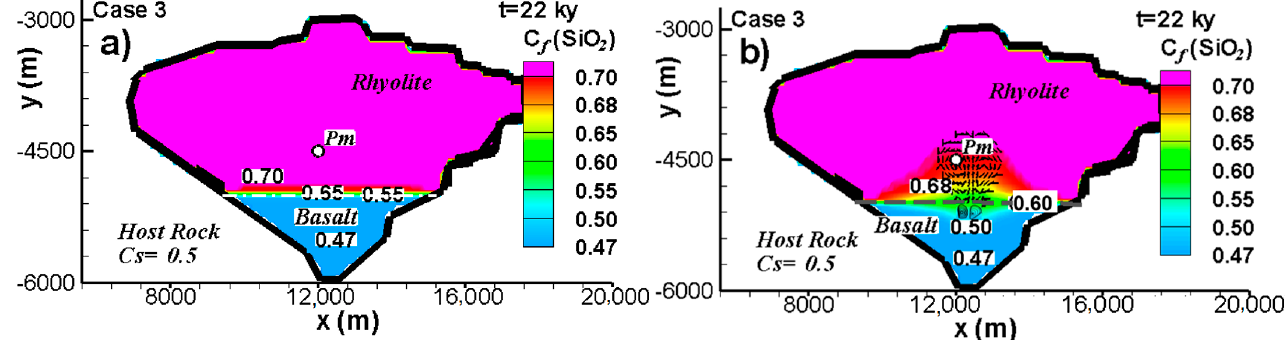
Figure 8. Silica concentration distribution (in wt fraction) within a magma chamber when basaltic magma is intruded into rhyolite magma without initially mixing and then the chamber is closed completely. Results for two diffusivities, ( a ) using D = 3 × 10 − 12 m 2 /s as a typical SiO 2 diffusivity for basaltic magma in rhyolite and ( b ) using D = 1 × 10 − 8 m 2 /s as an artificially high diffusivity. The original interface between the two magmas is shown as a dashed horizontal black line in Figure 8b. Streamlines show two vortices in the basaltic and rhyolitic magma that can be seen in Figure 8b. Our simulation results agree with experimental results that can be found elsewhere